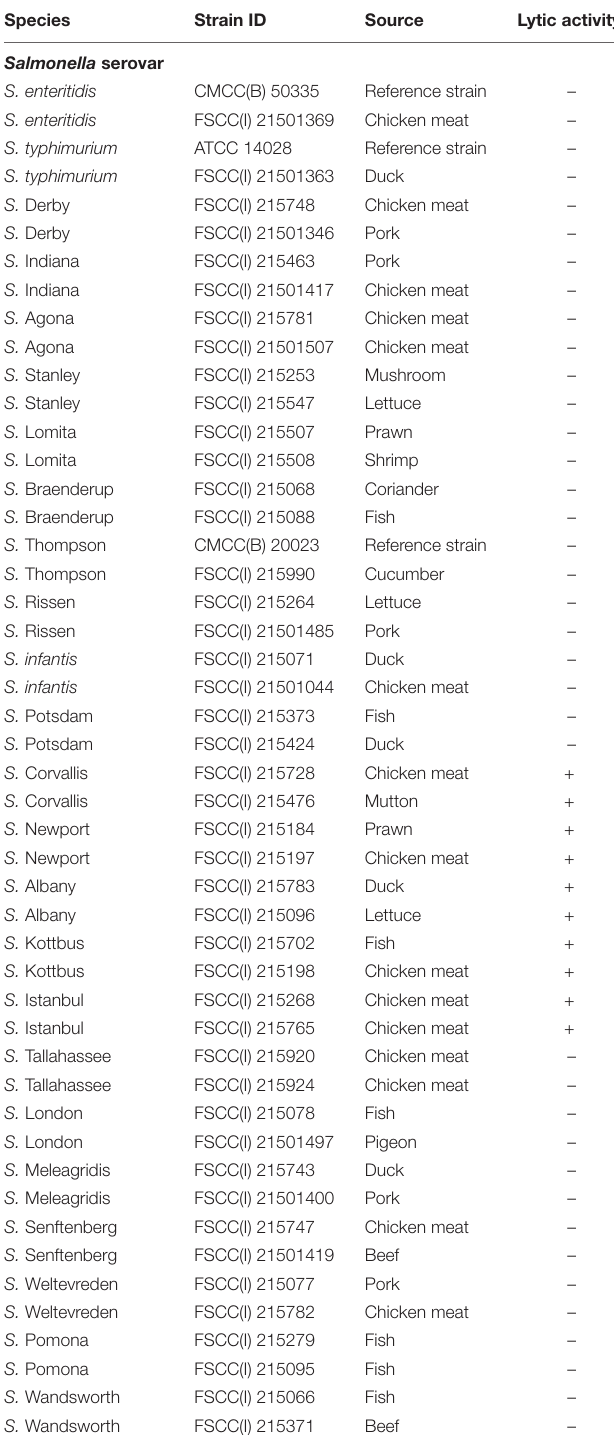
TABLE 1 | Host range analysis of Salmonella phage vB_SalP_TR2. Species Strain ID